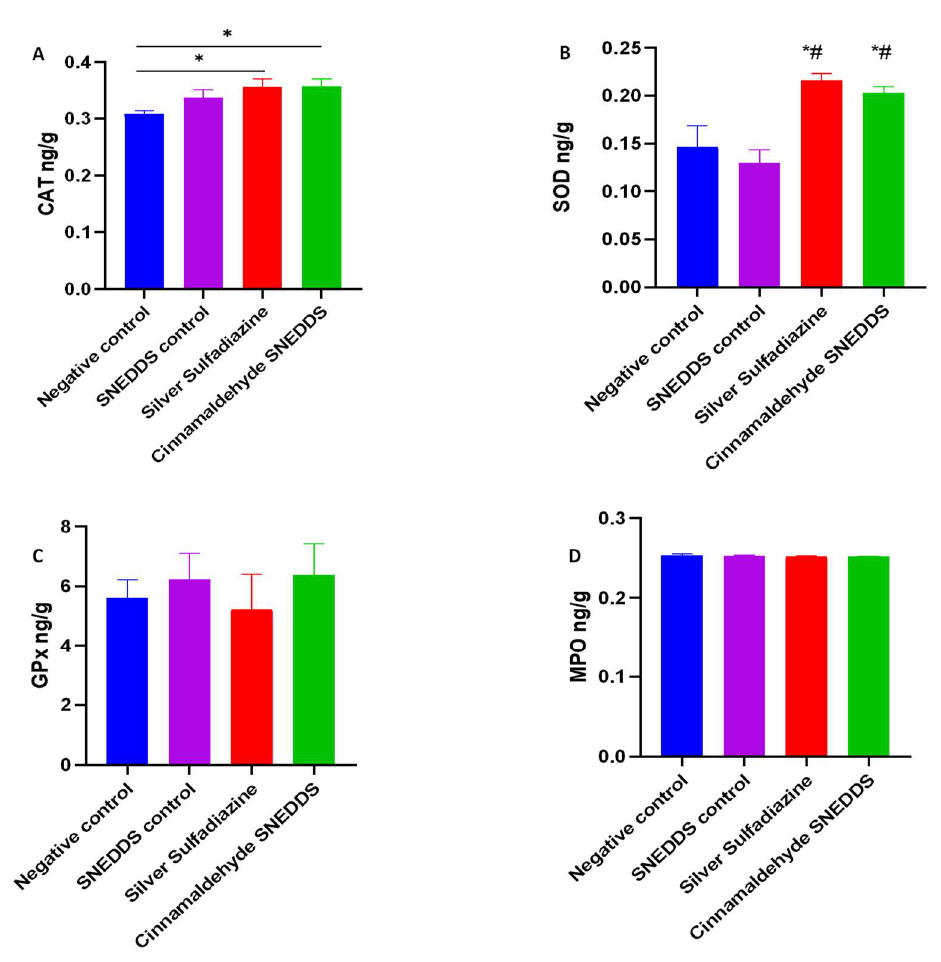
Figure 6. Effect of cinnamaldehyde on antioxidant and oxidant levels in the model of skin burn rats. Values are denoted as mean ± SEM, N = 5 rats per group. Statistical significance was found using one-way ANOVA, followed by a post hoc test in GraphPad Prism 8.0.2. ( A ) Catalase (CAT), ( B ) superoxide dismutase (SOD), ( C ) glutathione peroxidase (GPx), and ( D ) malonaldehyde peroxide (MPO). * p < 0.05 vs. negative control and # p < 0.01 vs. SNEDDS control using Tukey’s multi- group